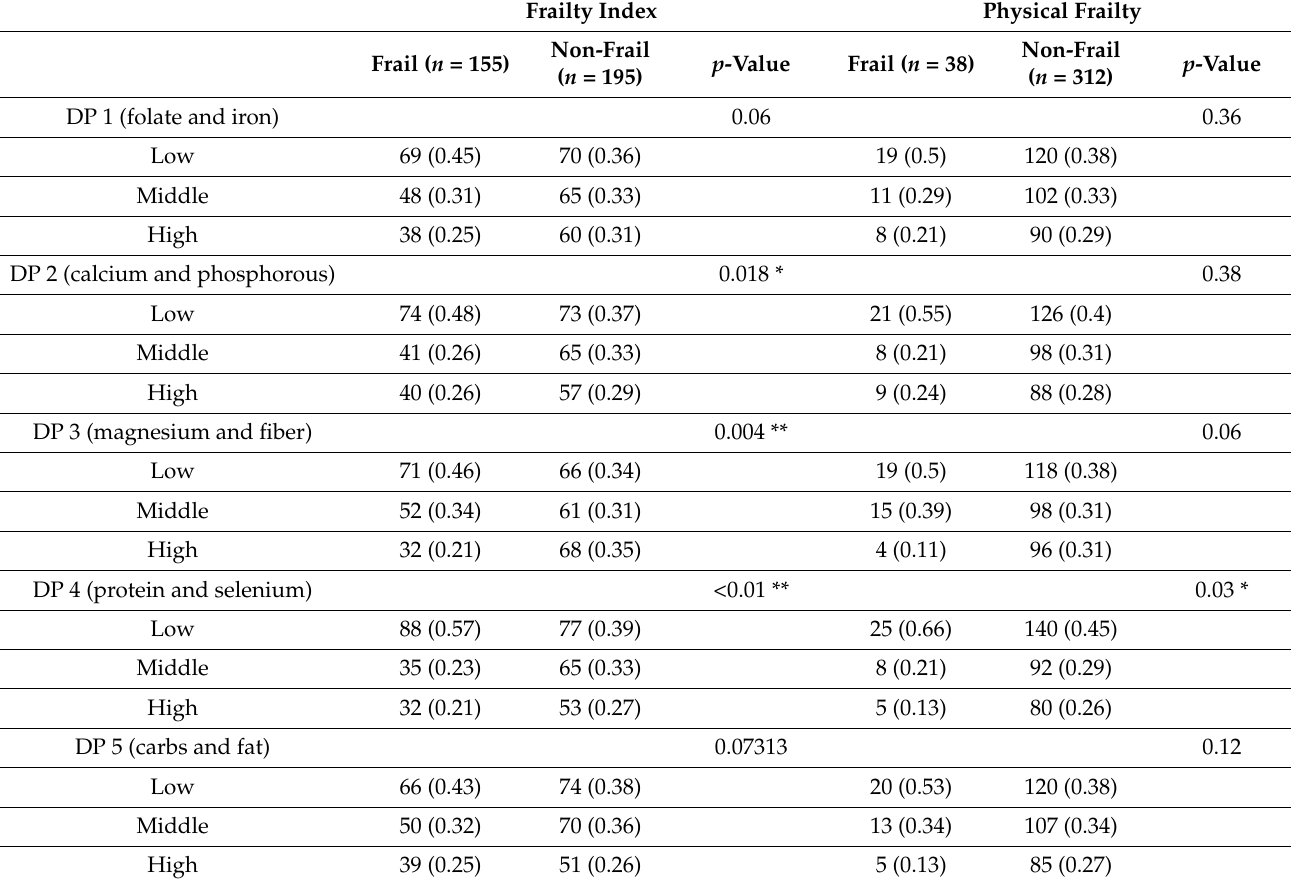
Table 4. Association between dietary patterns and frailty in adults with olfactory